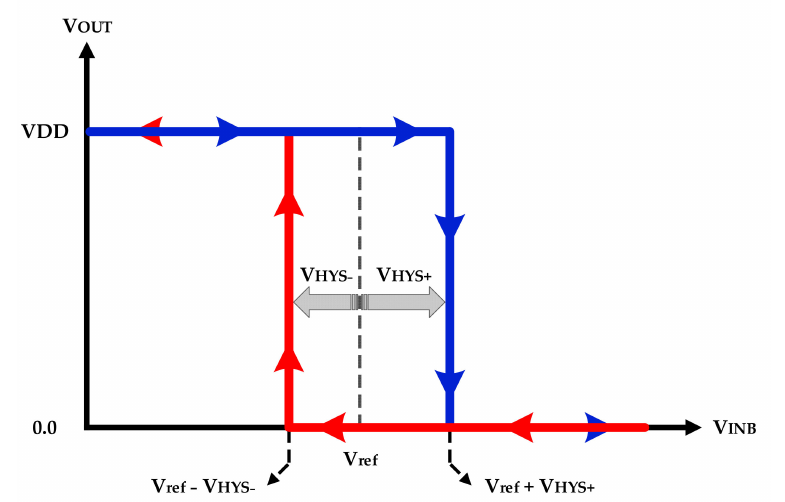
Figure 2. Loop characteristics of an inverting